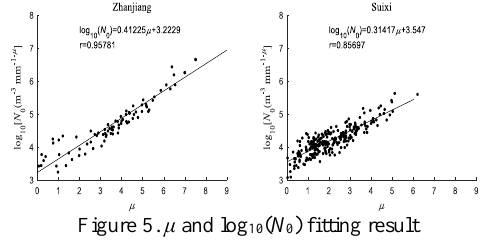
Figure 5. μ and log 10 ( N 0 ) fitting result